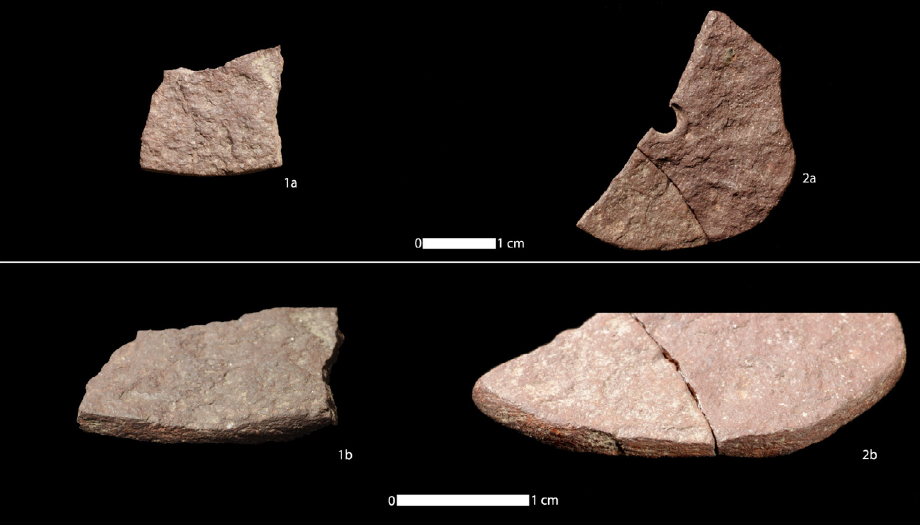
Figure 9. Hohle Fels, fragments of hematite rondelles, excavated 2010. Photo: M.